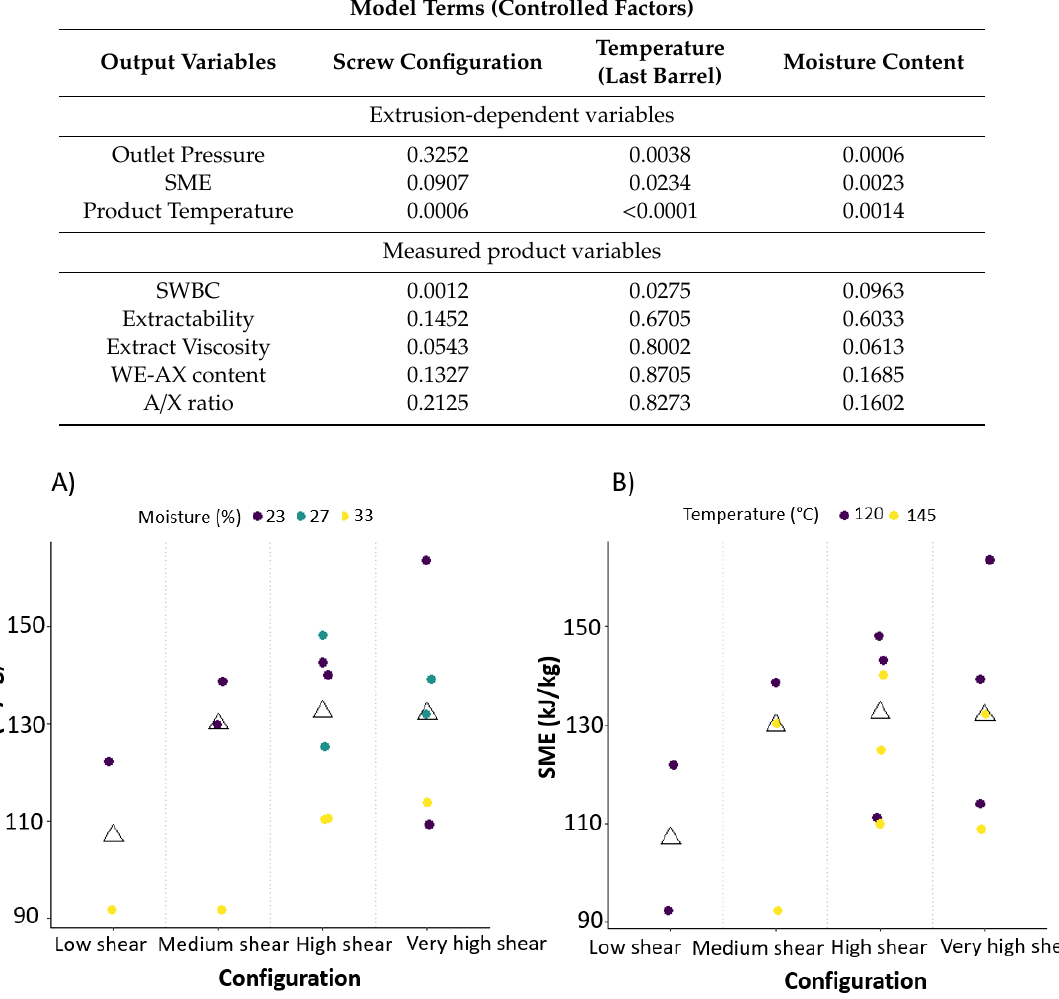
Figure 2. Scatterplot of the specific mechanical energy (SME) according to screw configuration. The triangles represent the median obtained by configuration. ( A ) Colouring of data points according to moisture in the extruder. ( B ) Colouring of data points according to temperature applied in the last barrel.